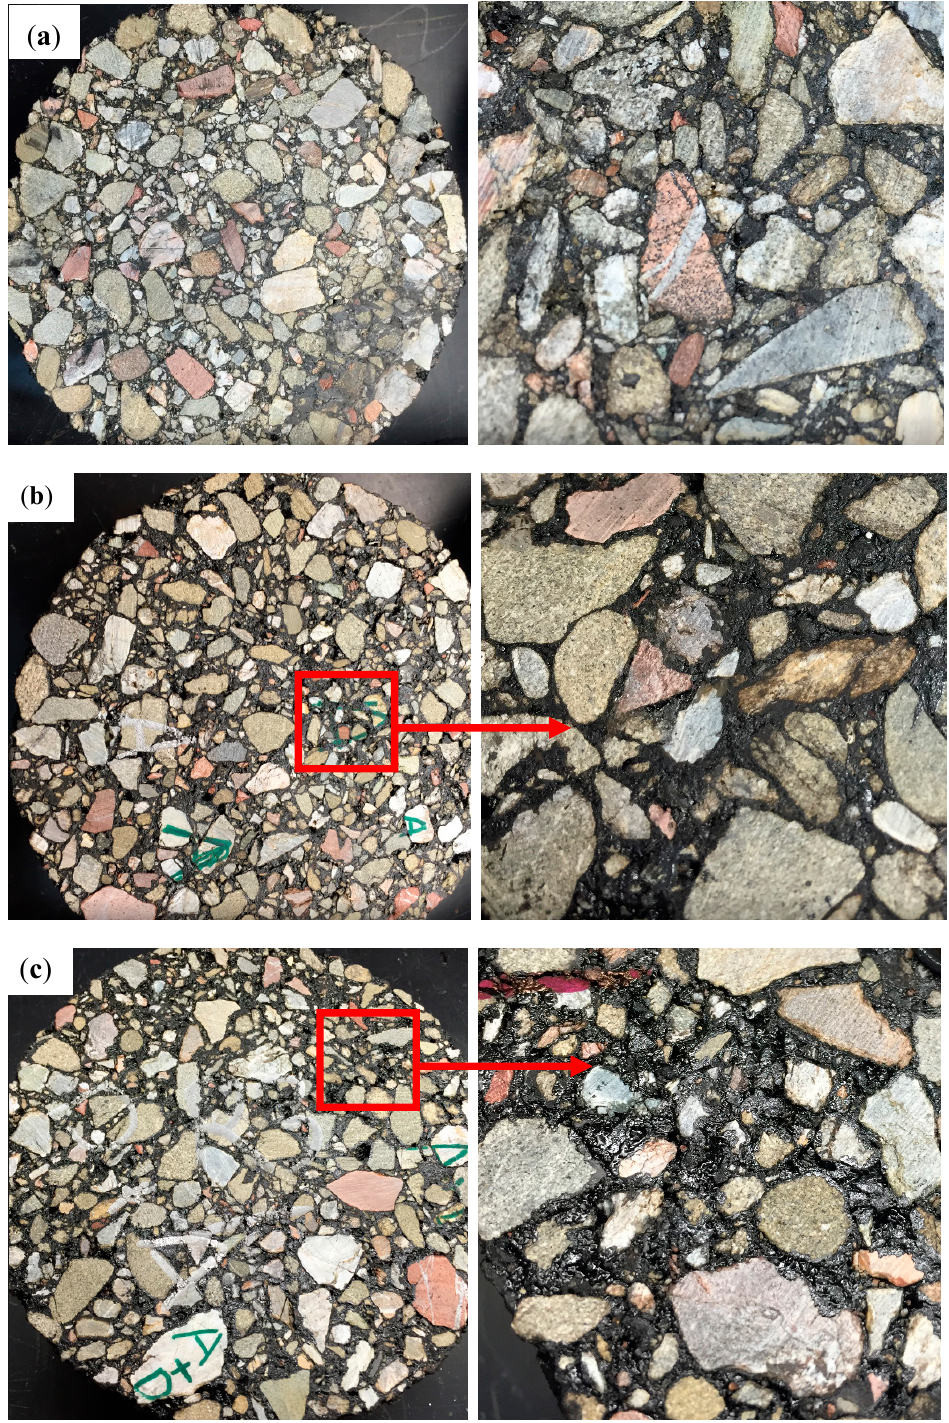
Figure 8. Surface characteristics photos of ( a ) Co sample, ( b ) aged sample, and ( c ) aged sample under dynamic load.